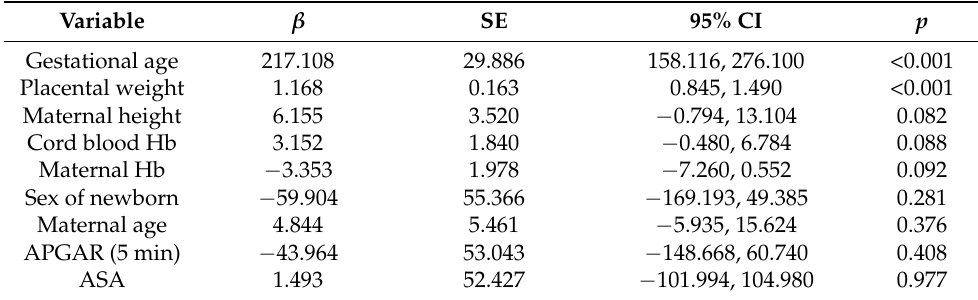
Table 3. Multiple linear regression analysis of birth weight ( r 2 = 0.51).